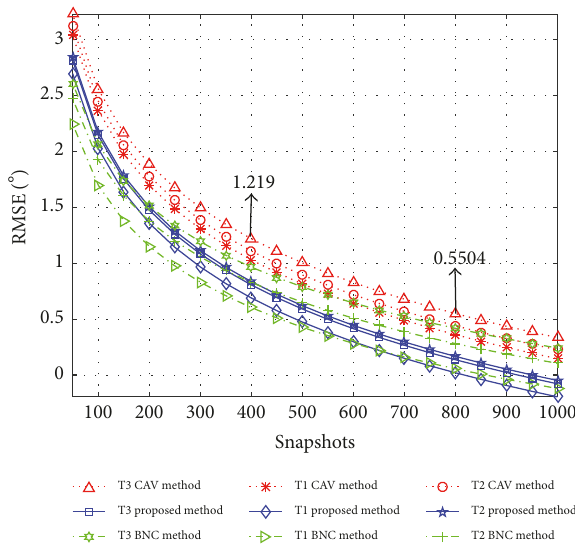
Figure 4: RMSE versus snapshots with the SNR fixed at